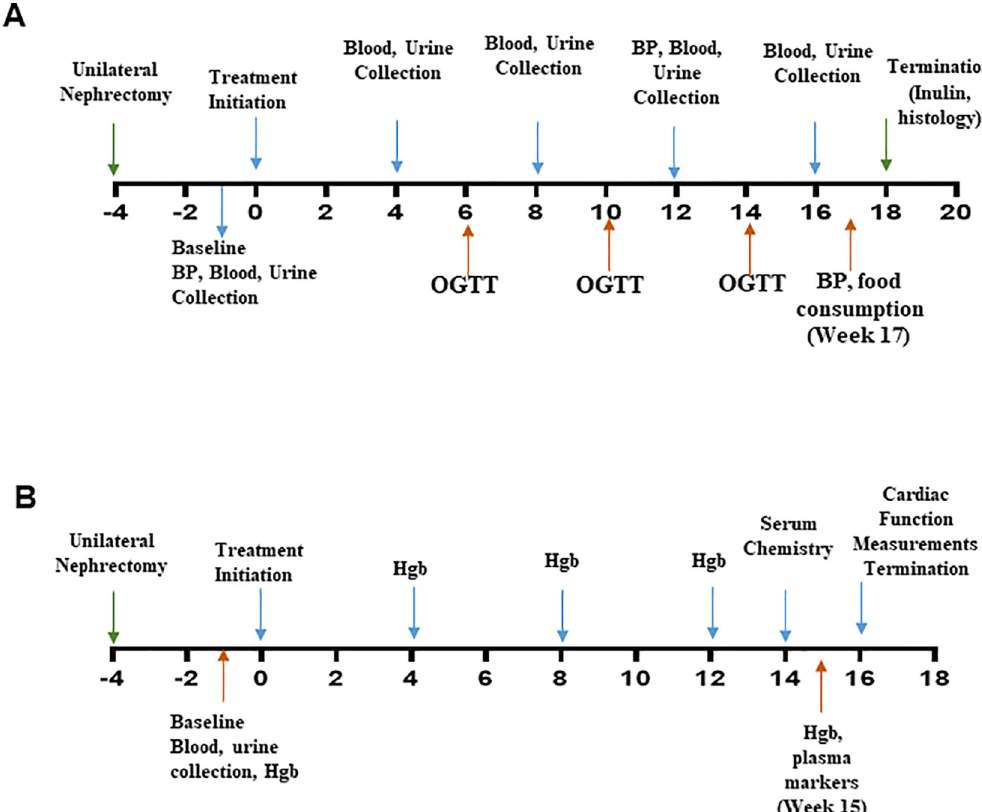
Fig 1. Experimental study design. Study design of renal (A) and cardiac (B)